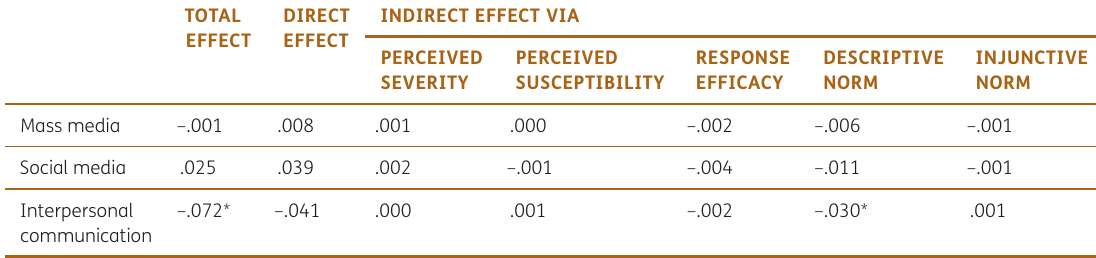
conference was released are marked with a vertical line and square boxes.